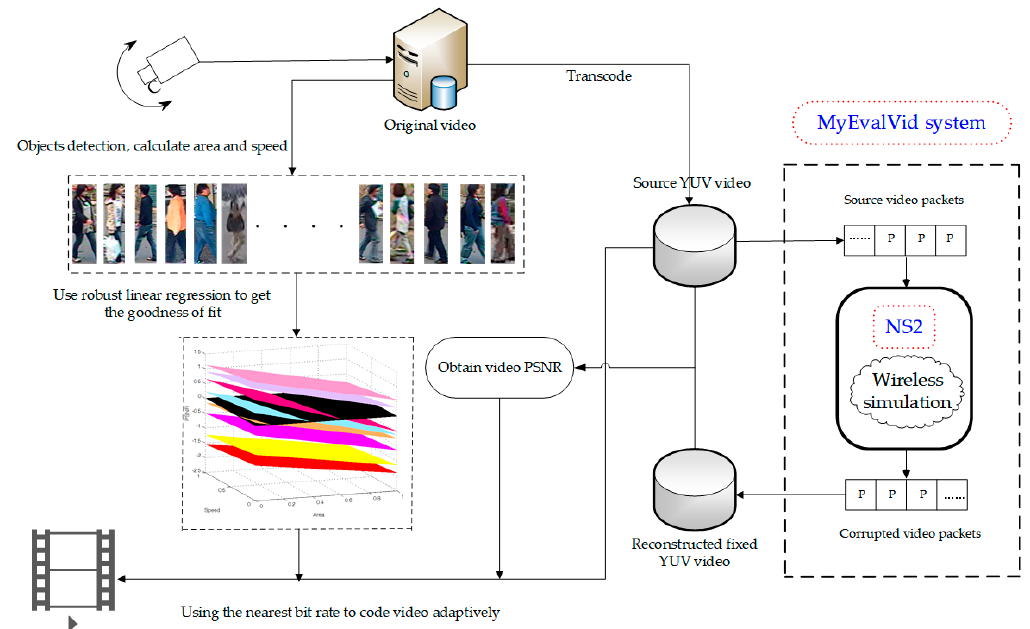
Figure 4. The experimental framework of our system.